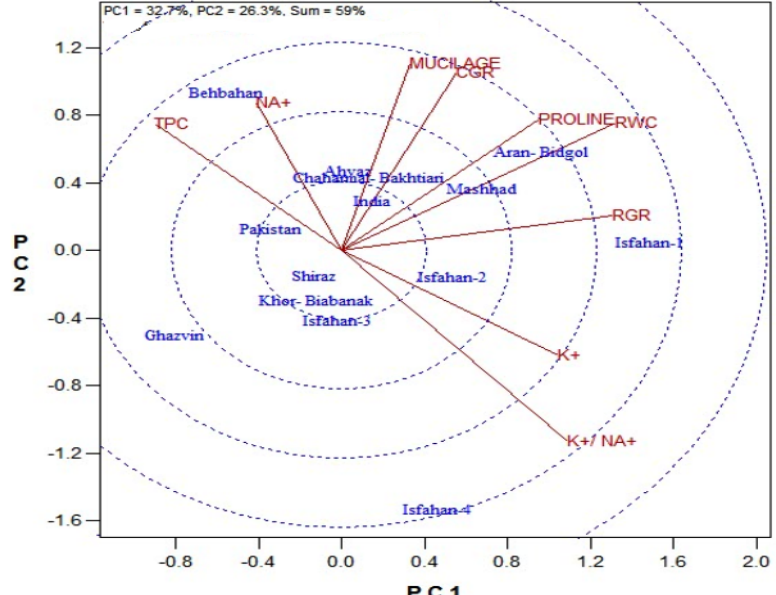
Fig. 3: Biplot drawn based on the first (PC1) and second (PC2) components obtained from principal component analysis using CGR, RWC, RGR, TPC, Mucilage Na + , K + , and K + /Na + ratio of psyllium genotypes under 200 Mm (NaCl) under in vitro conditions.